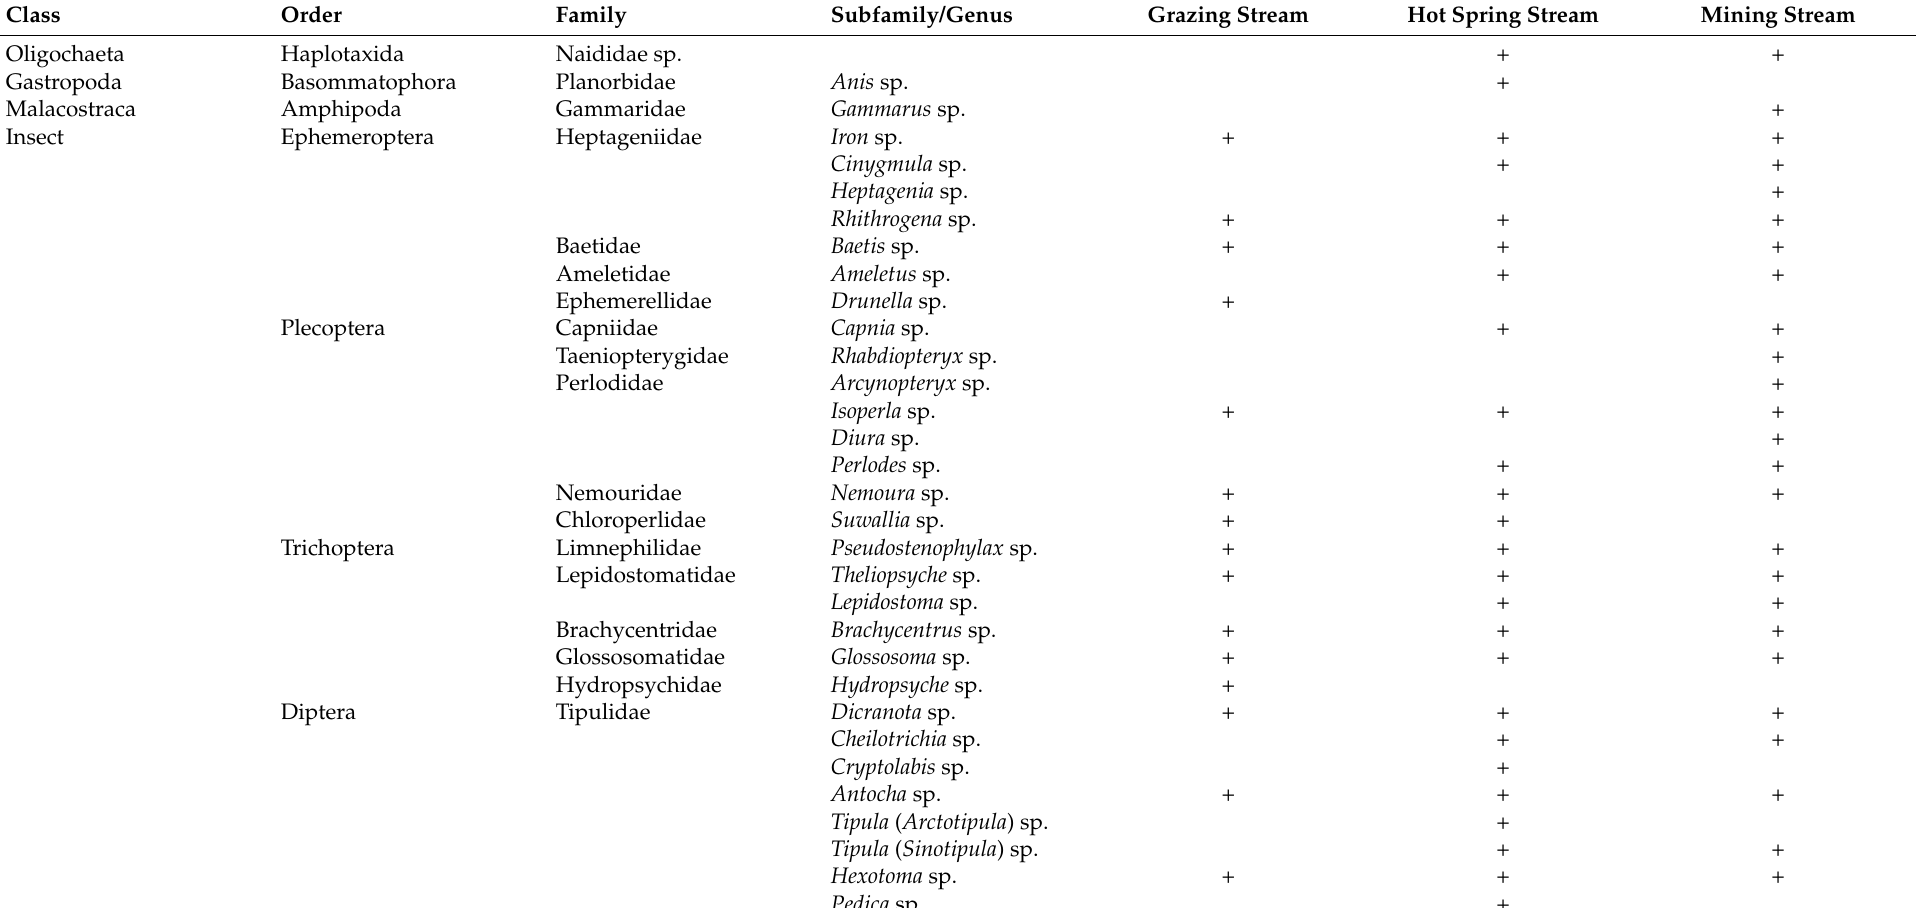
Table A1. Macroinvertebrate taxa list of the grazing stream, hot spring stream, and mining stream in